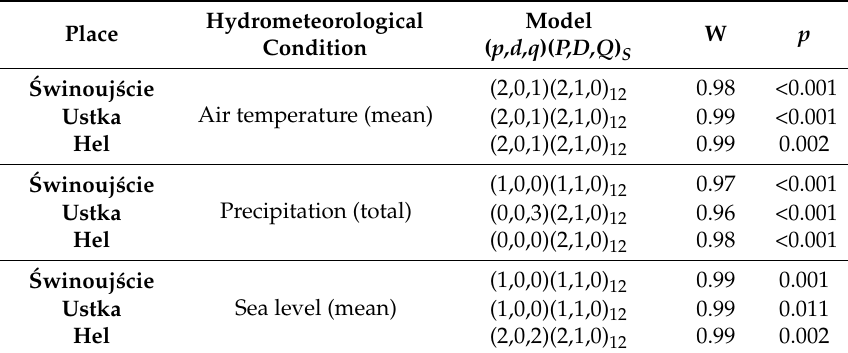
Verification of normality for the distribution of ARIMA model residuals using the Shapiro–Wilk